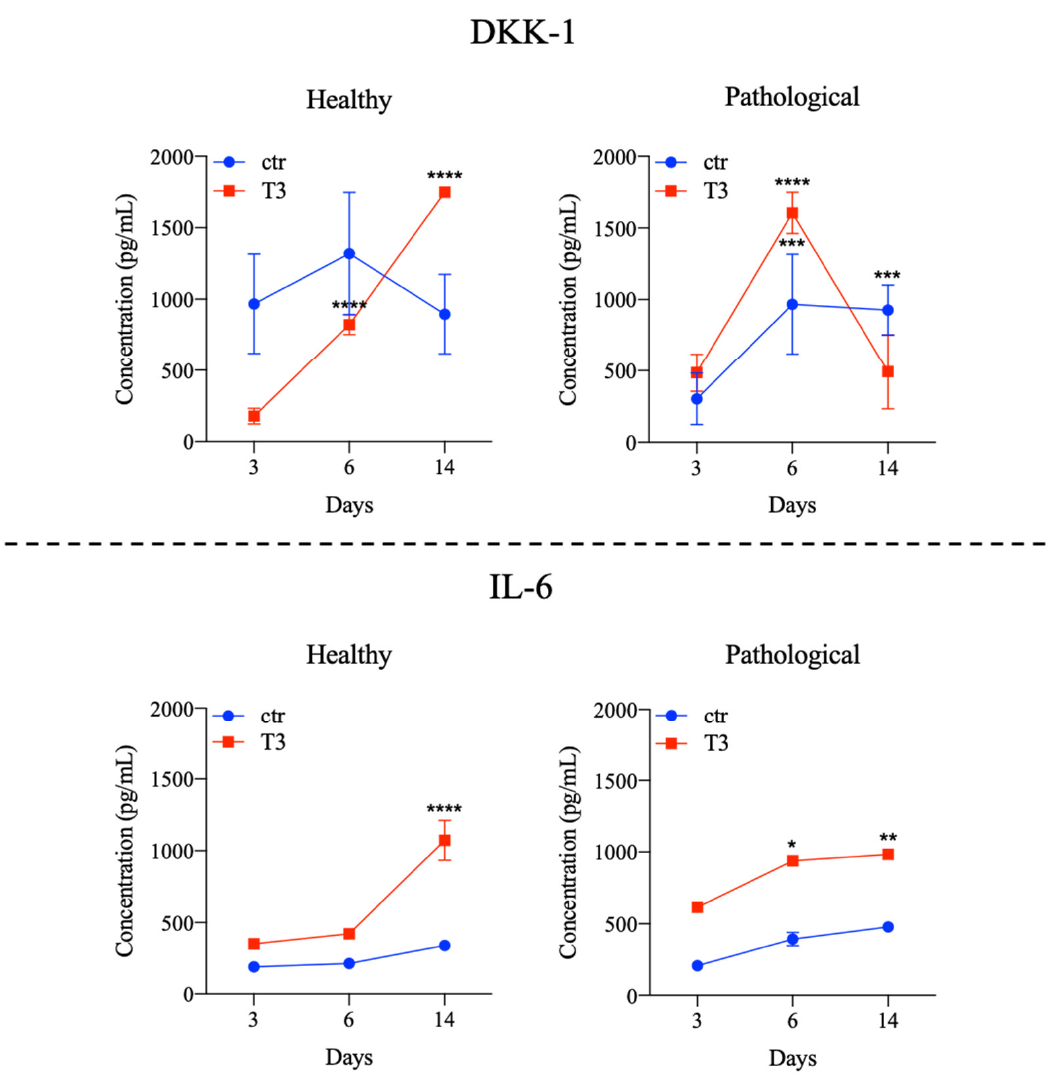
Figure 9. DKK-1 and IL-6 profiles of healthy and pathological tissue-derived tendon stem/progenitor cells (TSPCs) cultured in a medium supplemented with T3 (10 −6 M) up to 14 days. Cytokine levels (pg/mL) were measured in culture medium at various time points (3, 6, and 14 days) using a bead-based multiplex immunoassay. Results are shown as mean ± SD. * p < 0.05, ** p < 0.01, *** p < 0.001, and **** p < 0.0001 (N = 2).